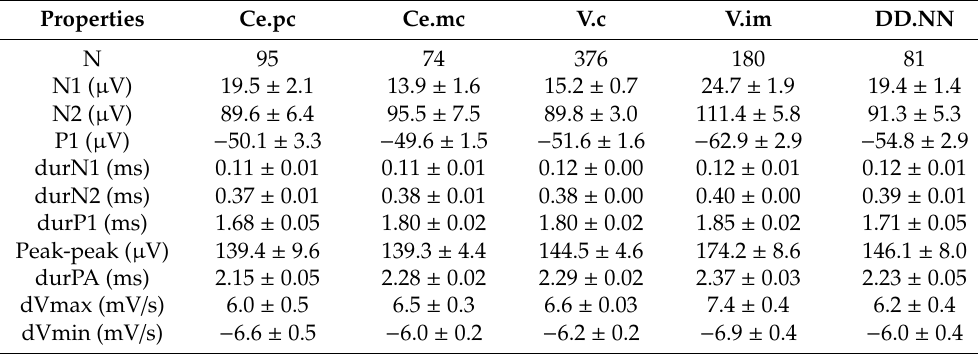
Table A2. Properties of mAP for P1P2N1. Values as x ± SEM , except of N , which indicates the number of mAP picked up from every nucleus.